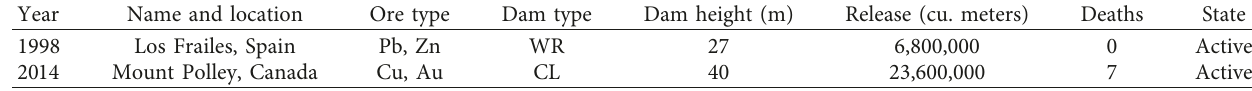
Table 3: Example of tailings dam failures caused by foundation